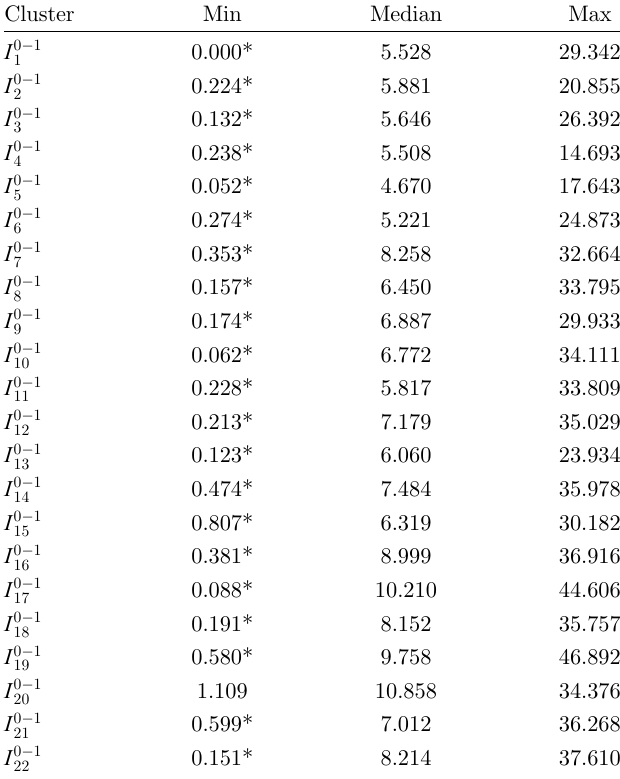
Table 12. By line (for i = 1, ... , k I ) for each cluster I 0 (cid:3) 1 reported the minimum, median and maximum value of d max computed between I 0 (cid:3) 1